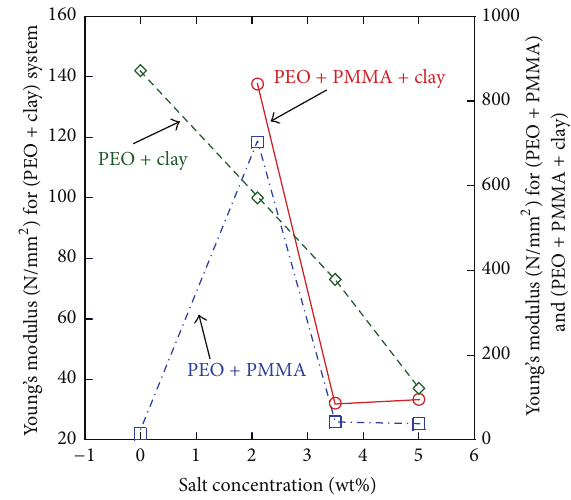
Figure 12: Variations of Young’s modulus for PEO/Clay (PC), PEO/PMMA, and PEO/PMMA/Clay (PPC) composite and blend composite system with varying content of